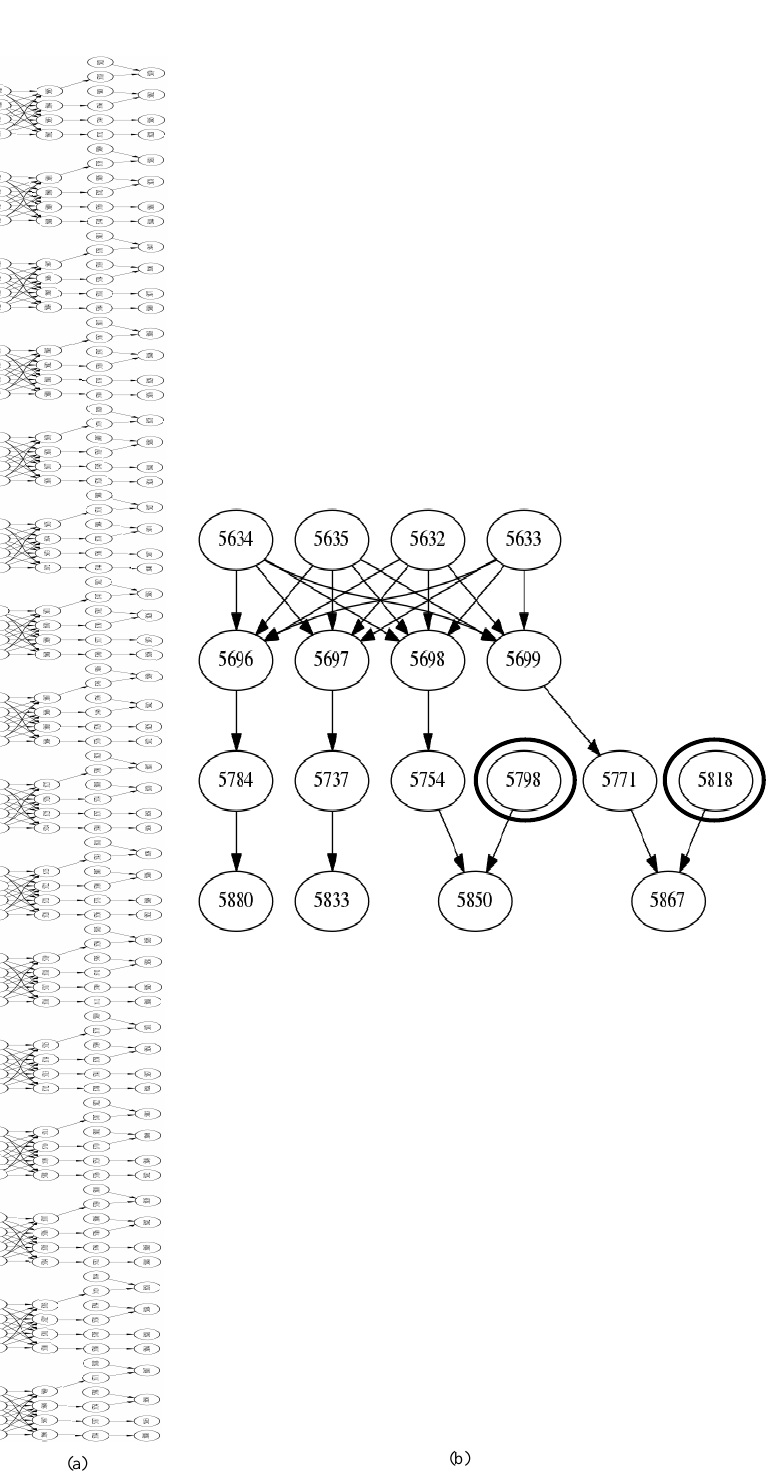
for the attack with a nibble fault injection 27